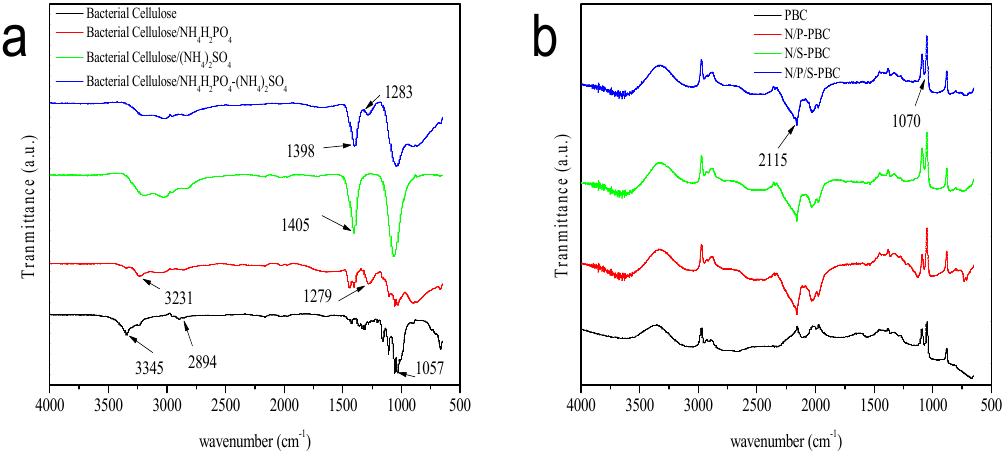
Figure 4. FTIR spectra of ( a ) BC, N/P-BC, N/S-BC, N/P/S-BC and ( b ) PBC, N/P-PBC, N/S-PBC, N/P/S-PBC.